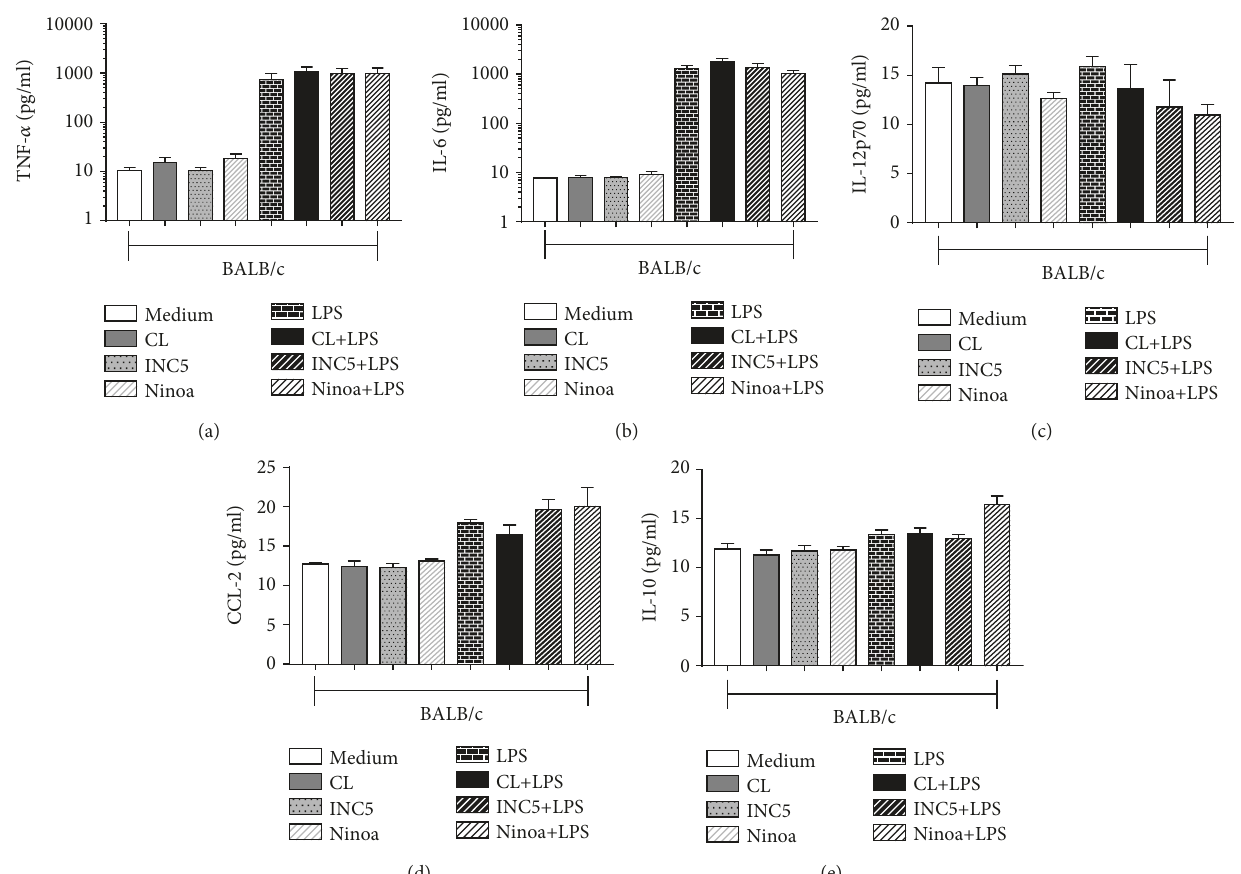
Figure 2: Cytokine and chemokine production by BALB/c-derived BMDCs infected with CL-Brener, Ninoa, and INC5 strains of T cruzi . BMDCs with or without LPS stimulation (5 μ g/mL) were incubated for 18h with di ff erent T. cruzi strains (MOI 2:1), and the production of cytokines and chemokine was evaluated by CBA: (a) TNF- α , (b) IL-6, (c) IL-12p70, (d) CCL-2, and (e) IL-10. Statistical analysis, when applicable, was performed with the Kruskal-Wallis test with Dunn ’ s posttest, where ∗ , ∗∗ p < 0 05